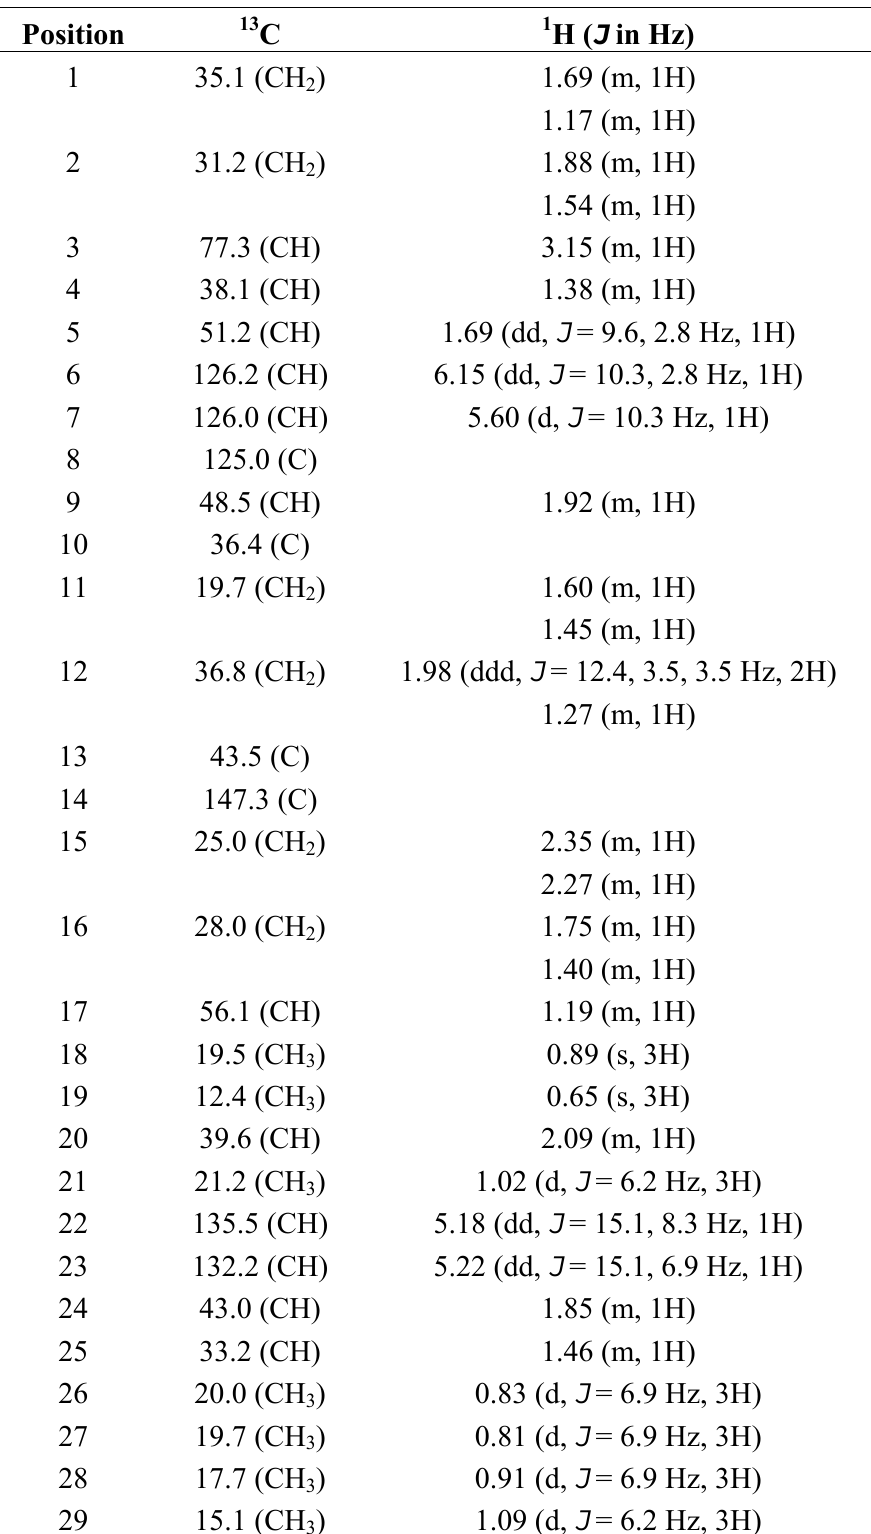
Table 1. 1 H NMR and 13 C NMR spectral data of compound 1 (recorded at 600/150 MHz in ;  in ppm, J in CDCl 3